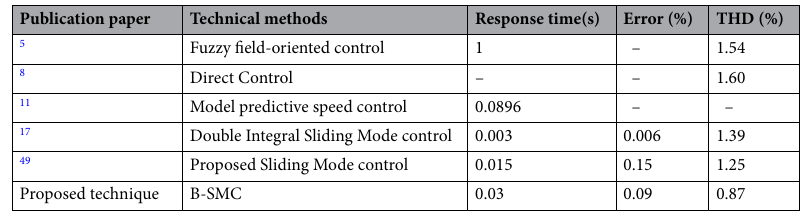
Table 2. Control’s